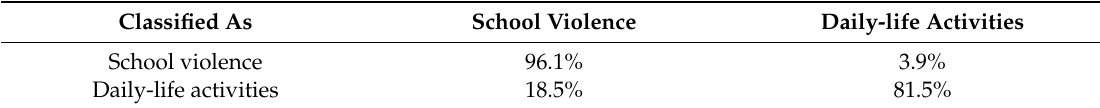
Table 6. Confusion matrix of SVM (Support Vector Machine) classification.